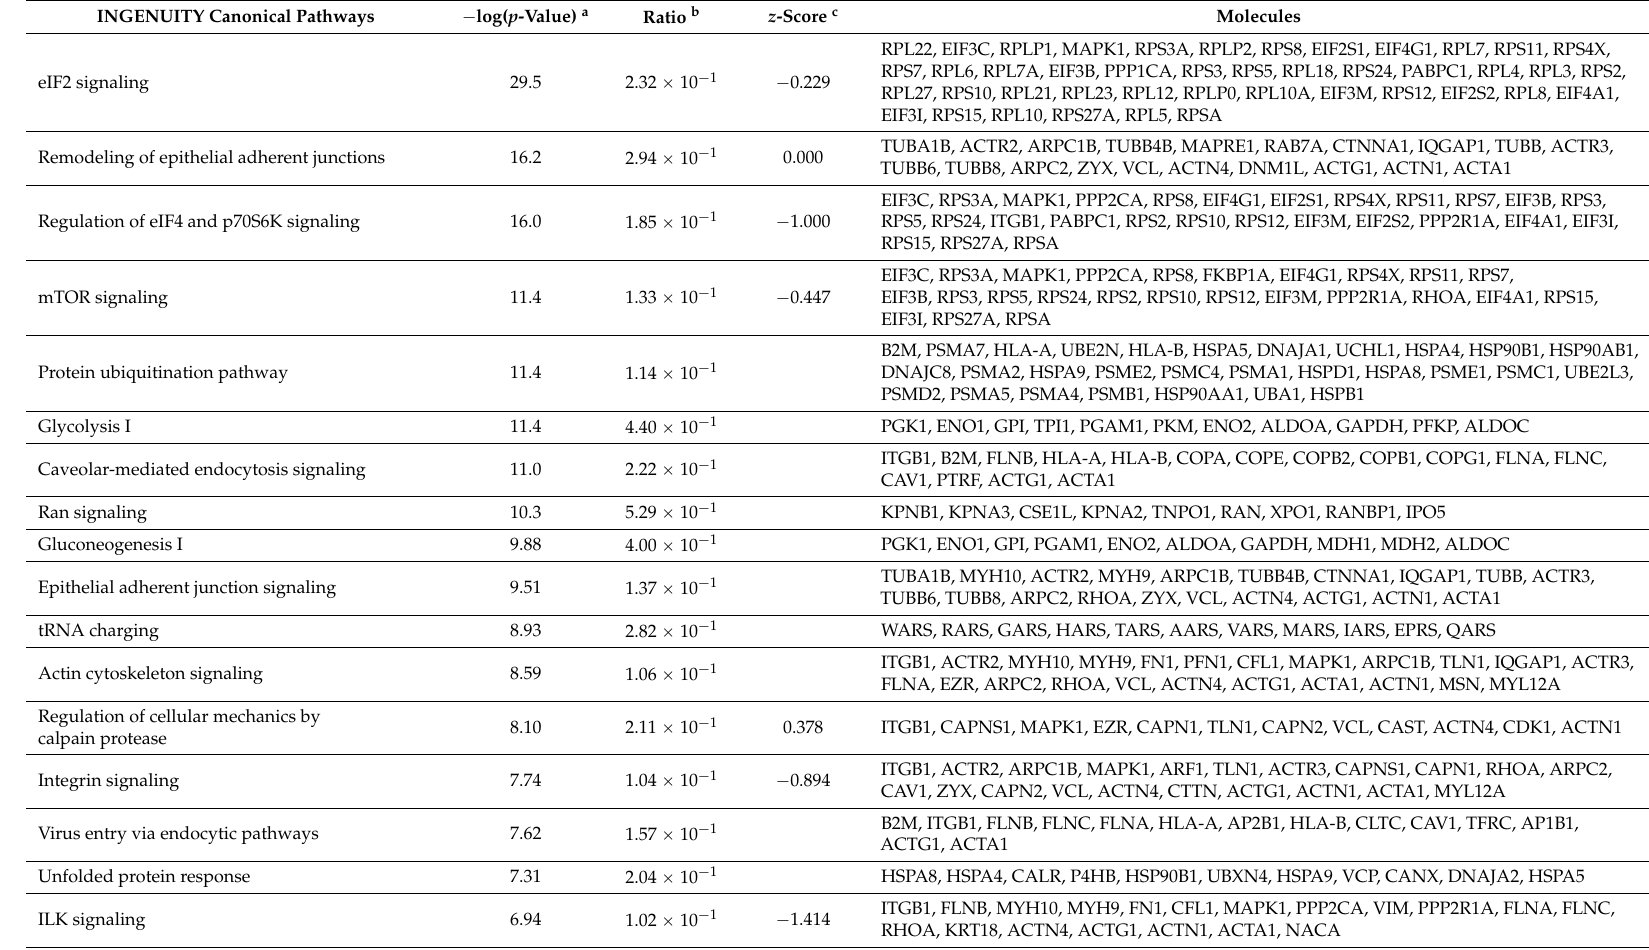
Table 3. 290 canonical signaling pathways regulated by vancomycin in HK-2